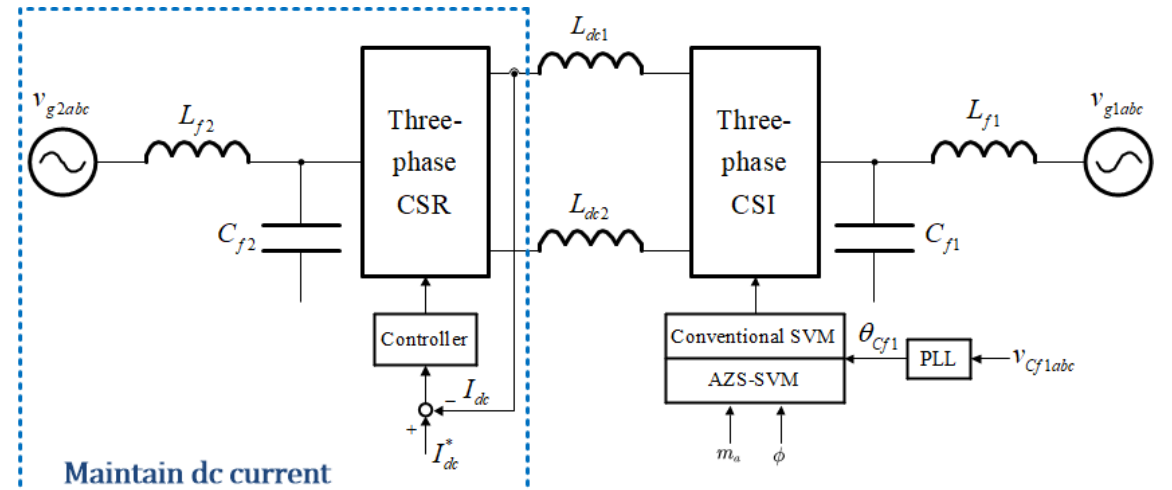
Figure 7. Diagram of the simulation system. Table 2. System parameters.